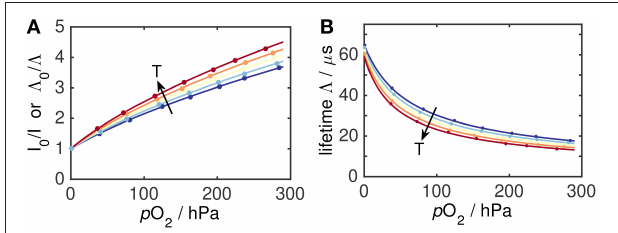
FIGURE 4 | Optode oxygen and temperature dependence (blue–cold, red–warm) as Stern-Volmer plot (A) and as plot of lifetime 3 against O 2 (B) . Dots indicate the location of actual optode calibration data at 1, 8, 15, 22, and 30 ◦